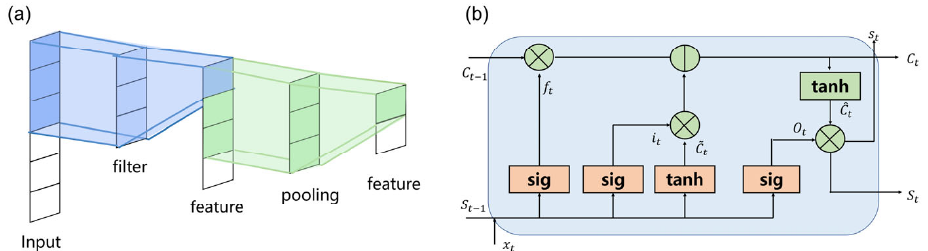
Figure 1. Schematic of LSTM and CNN. ( a ) Schematic of 1d-CNN. ( b ) Schematic of an LSTM